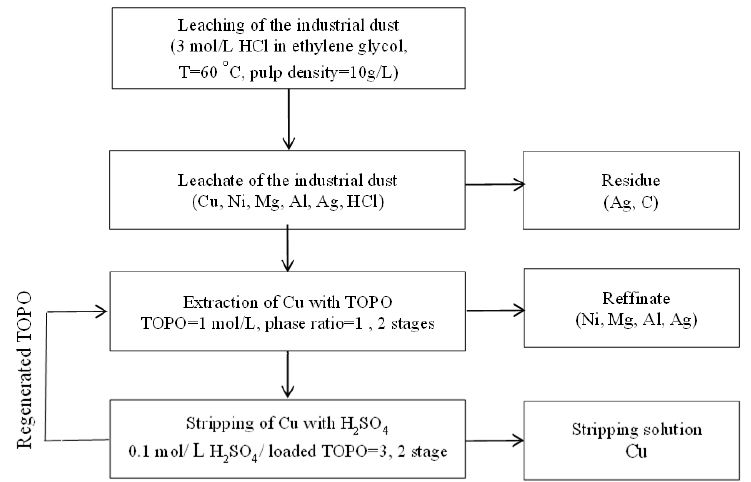
Figure 13. The proposed process for the separation of Cu from industrial dust.